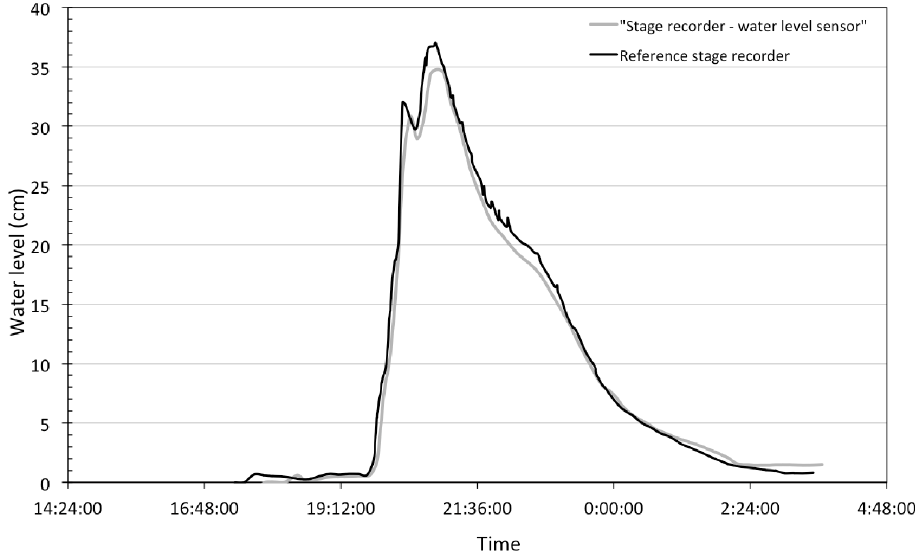
Figure 7. Stage recorder field test carried out at the Roujan catchment. Comparison, over a period of two days with a 1-minute data acquisition step, between the stage recorder using the capacitive sensor and a reference stage recorder (INRA